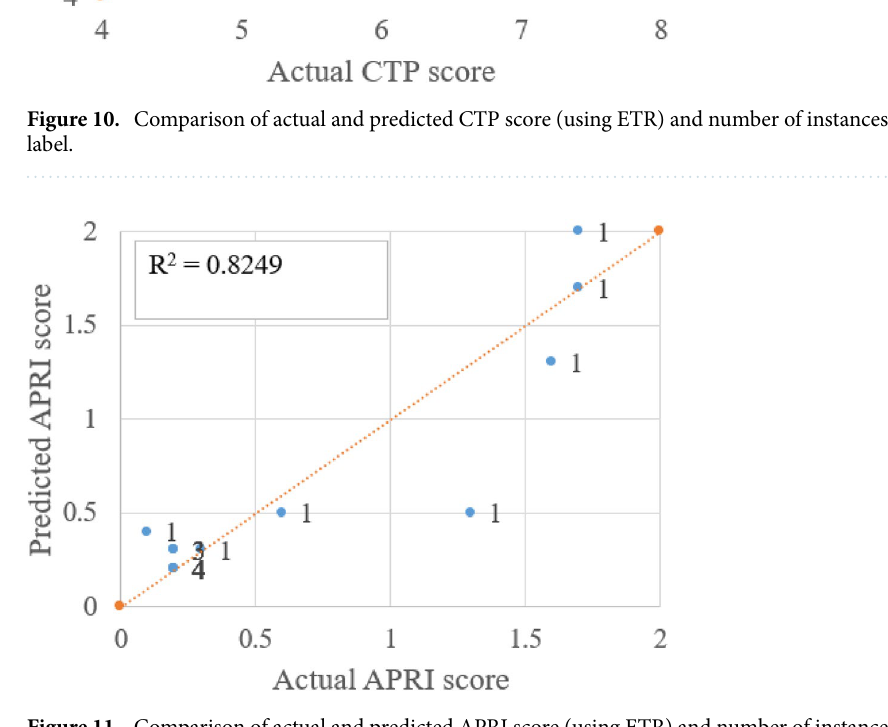
Figure 11. Comparison of actual and predicted APRI score (using ETR) and number of instances shown as